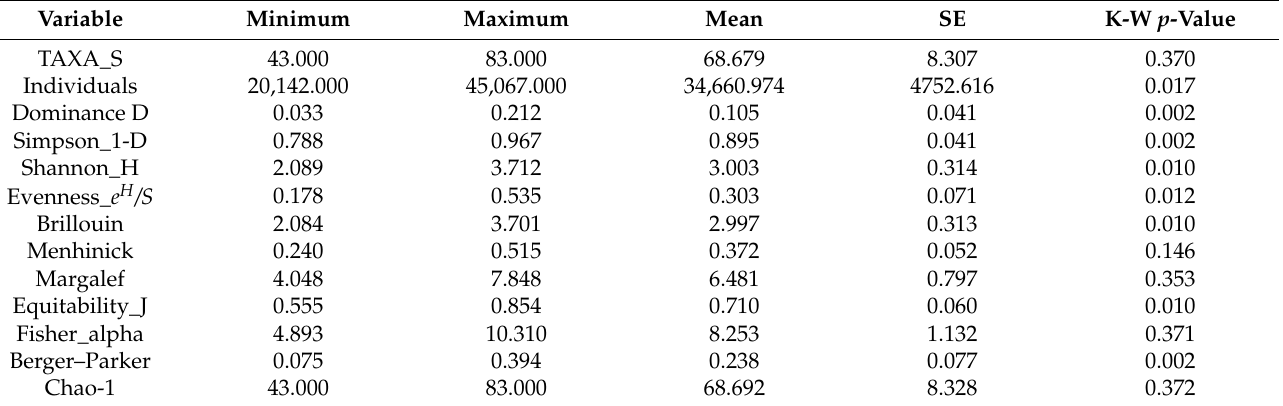
Table 2. Alpha diversity indices obtained in the randomised, placebo-controlled, single-blind trial to study the effect of oral intake of L. pentosus LPG1 on the human gut microbiota. The table shows their minima, maxima, means, and standard deviations. Besides, it includes the p -value of comparing the values for such indices according to treatments (AI, AF, BI, and BF for their respective groups and trial phases) using the Kruskal-Wallis test. Significant ( p < 0.05) differences between at least one of the contrasts between treatments are indicated in